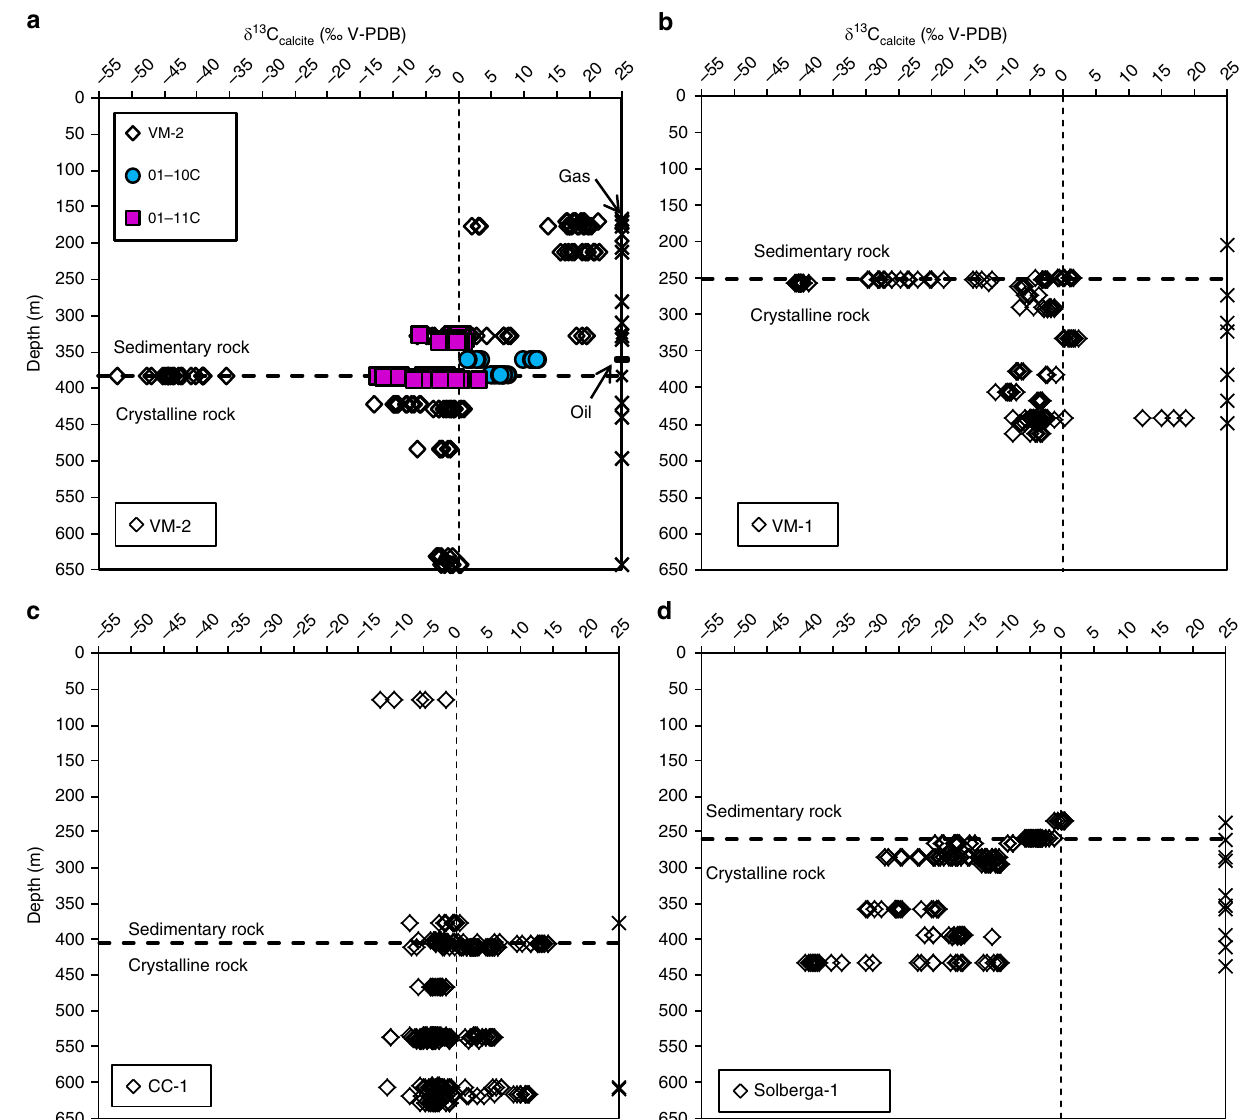
Fig. 4 δ 13 C calcite vs depth. a Closely spaced boreholes VM2, 01 – 10C and 01 – 11C (samples from the latter two have been depth-normalized to the sedimentary-crystalline rock interface in VM-2 in order to plot them in the same graph), ( b ) VM1, ( c ) CC1, and ( d ) Solberga-1, with Solberga quarry samples collected at close to ground surface, ~400 m south of Solberga-1 drill site. Each data point represents one SIMS analysis. Fractures with gas occurrences observed during drilling are marked with “ x ” (including a seep oil observation from borehole 01 – 10C/VM3, marked “ − “ ) on the right-hand side of the graphs and the depth of the sedimentary-crystalline bedrock interface is also indicated. Errors (2 σ ) are within the size of the symbols. All plots have the same range on the axes for